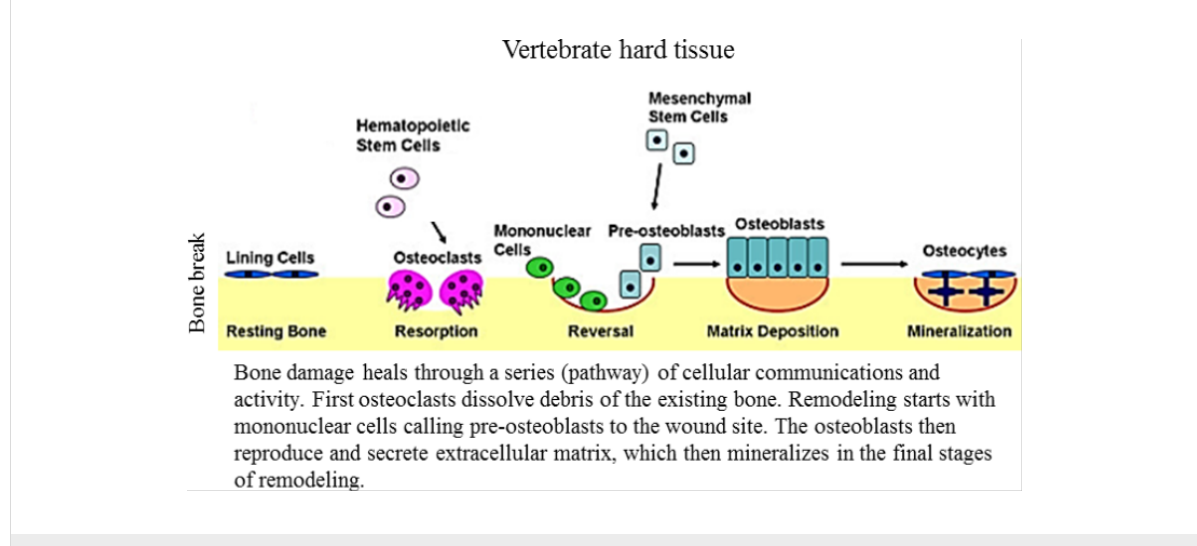
Figure 3: Healing in vertebrate hard tissue showing the stages of bone tissue repair. Healing stages include mechanisms to stabilize the sides of the bone injury until the remodeling phase completes, restoring form and function to the bone tissue. Adapted from [53].